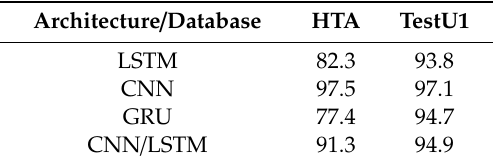
Table 4. Test accuracy results when training on the TrainU1 dataset while using both accelerometer and gyroscope